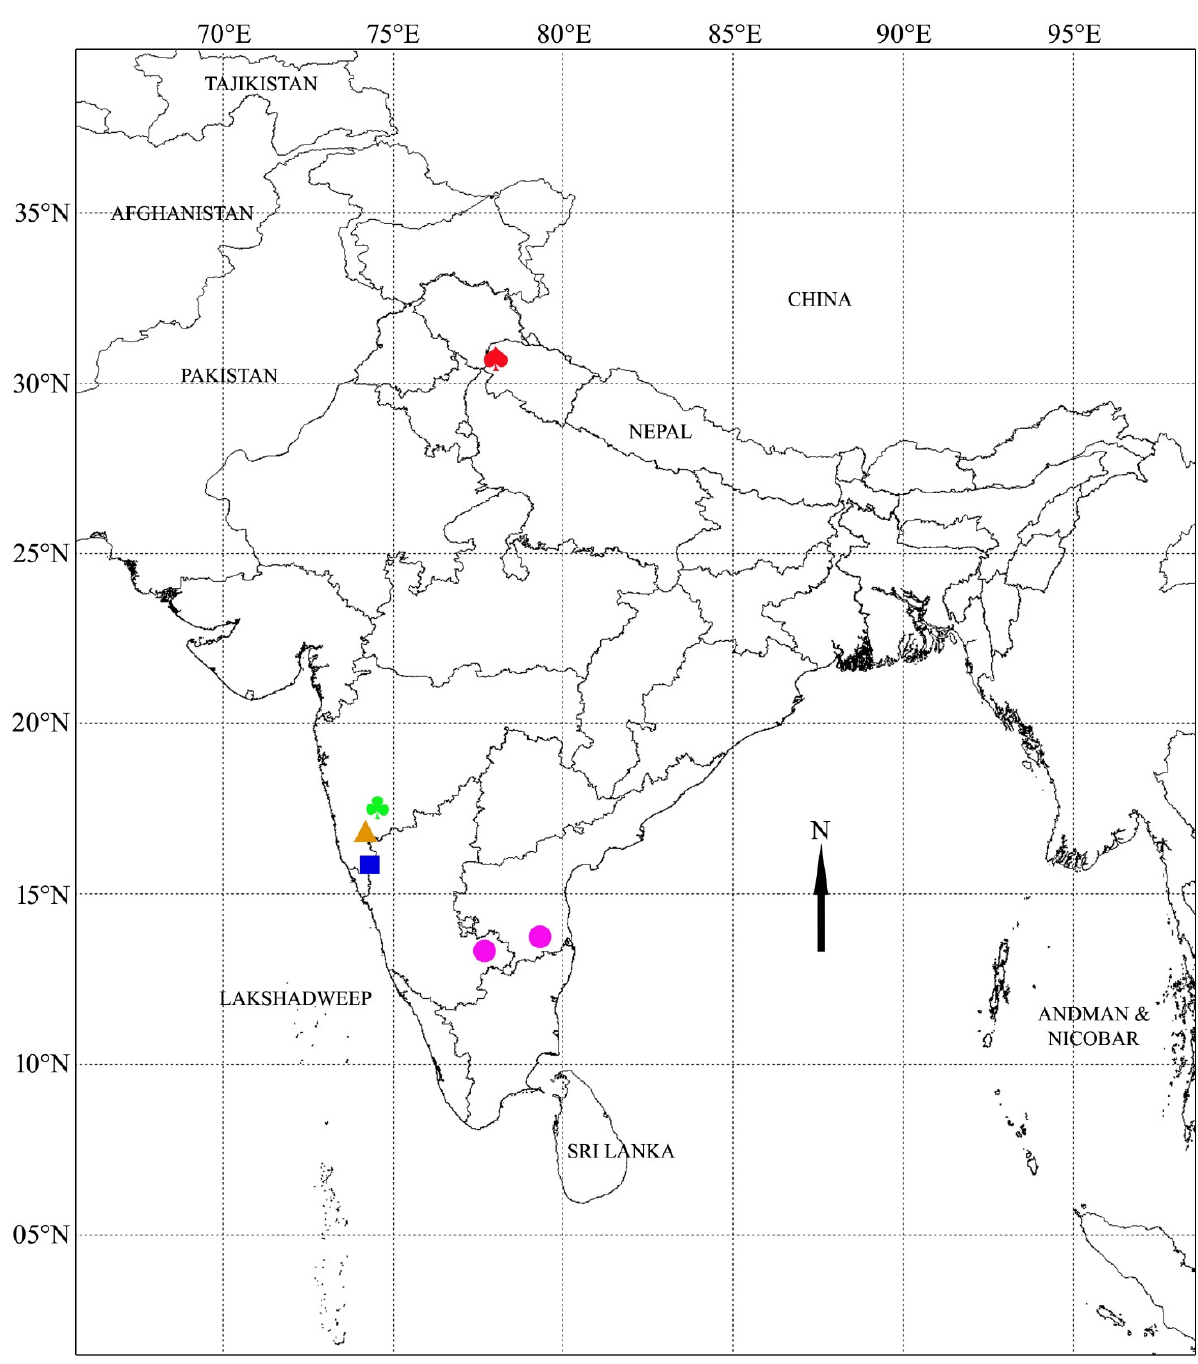
Figure 1. Distribution of Barleria cristata morphotypes. ■ B. cristata (cultivated form 1); ♣ B. cristata (cultivated form 2); ▲ B. cristata (cultivated form 3); ● B. cristata (Nandi Hills); ♠ B. cristata (Uttarakhand).